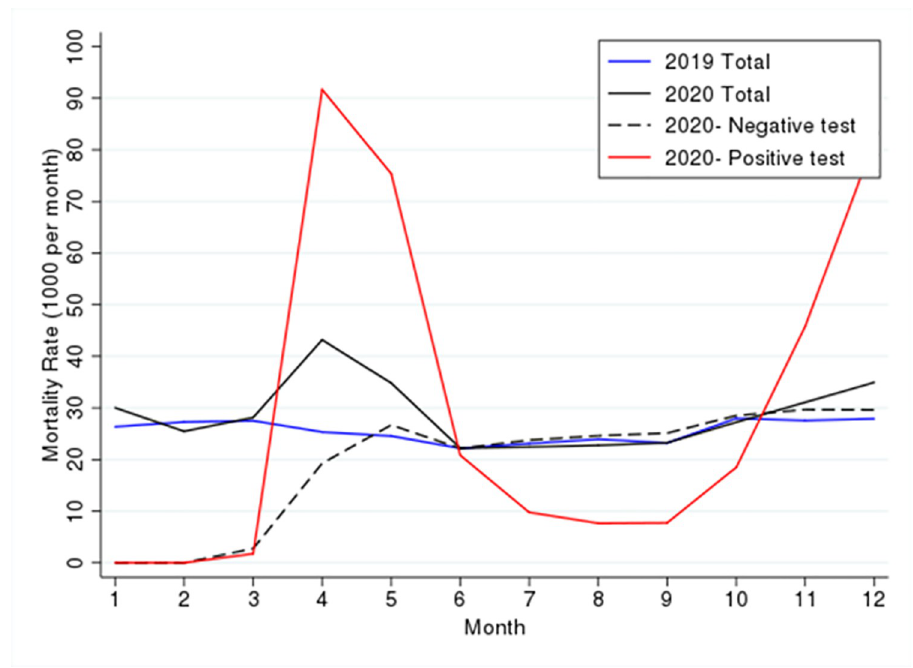
Fig 1. Crude mortality rate based on year and COVID-19 test